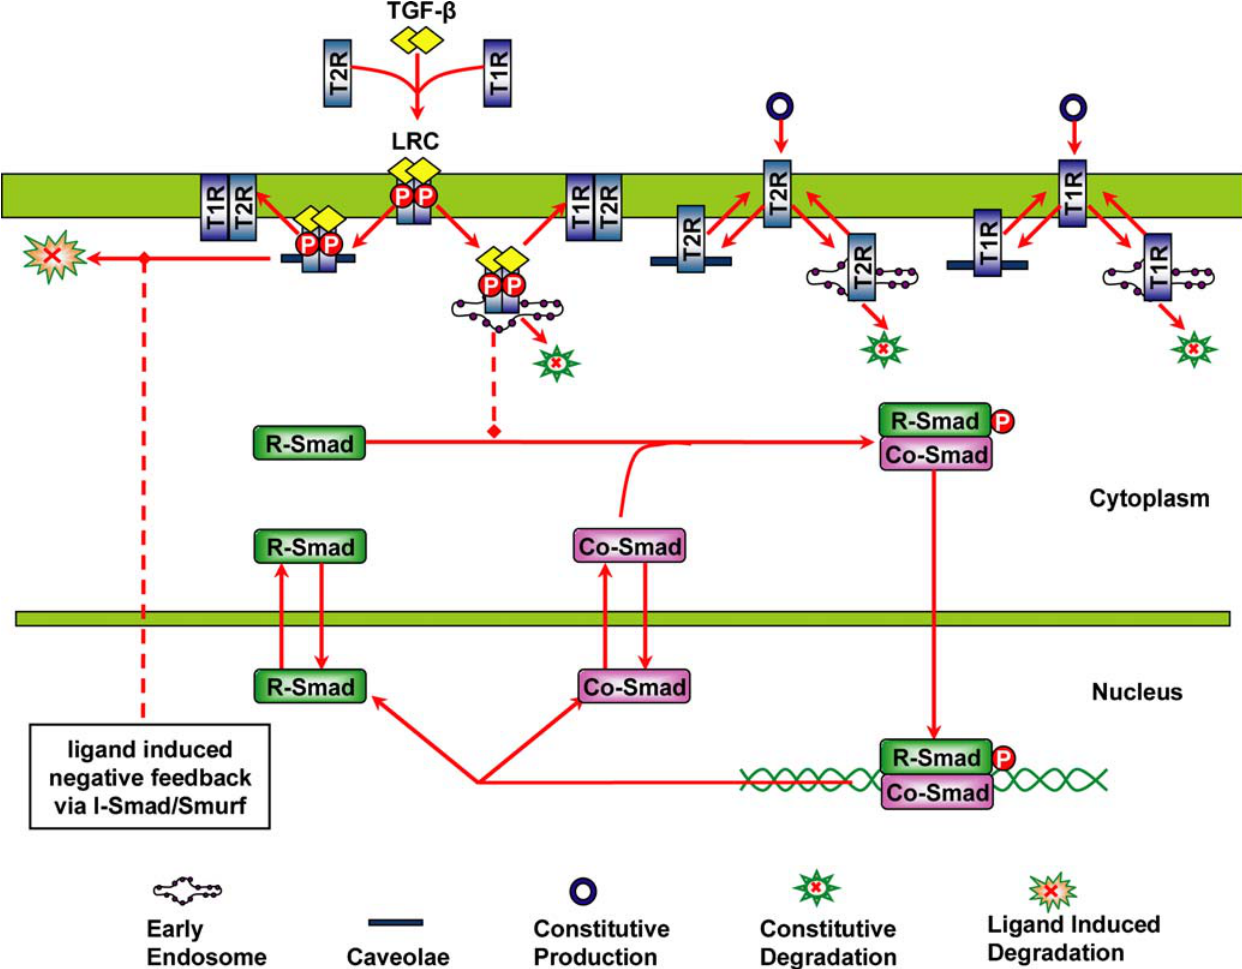
Figure 1. Schematic representation of Smad dependent TGF- b signaling pathway. Detailed information about this pathway is described in the text.